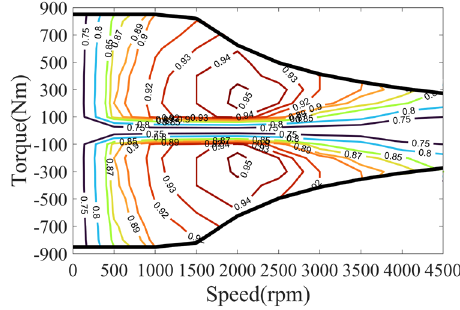
Figure 3. The efficiency MAP of the motor.